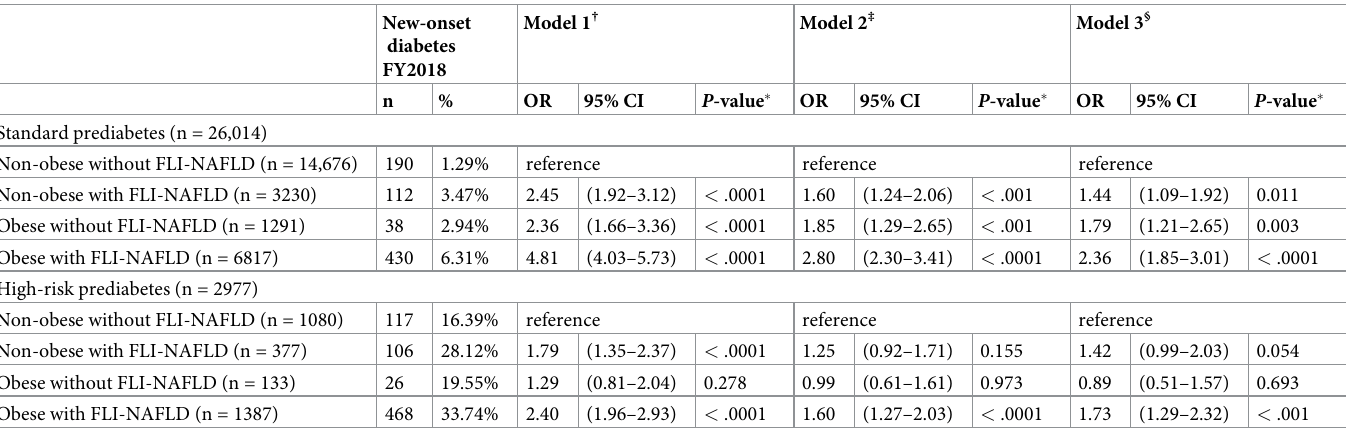
Table 3. Multivariate adjusted logistic regression model for the incidence of new-onset diabetes by the combination pattern of obesity and FLI-NAFLD.